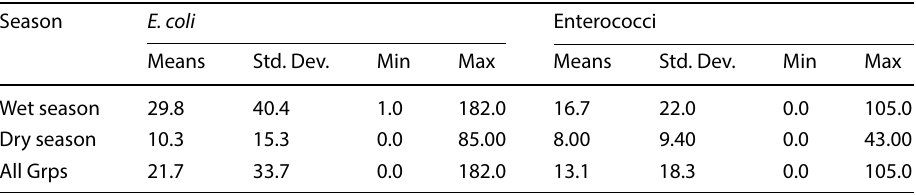
The mean FIB values were significantly different between seasons ( p <